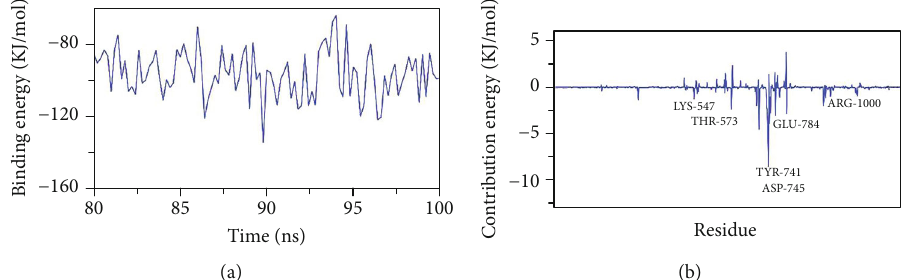
Figure 18: (a) Total binding energy plot of proanthocyanidin-C1 bound with 7T9K at 100-ns time frame. (b) Contribution energy plot with interacting amino acids.